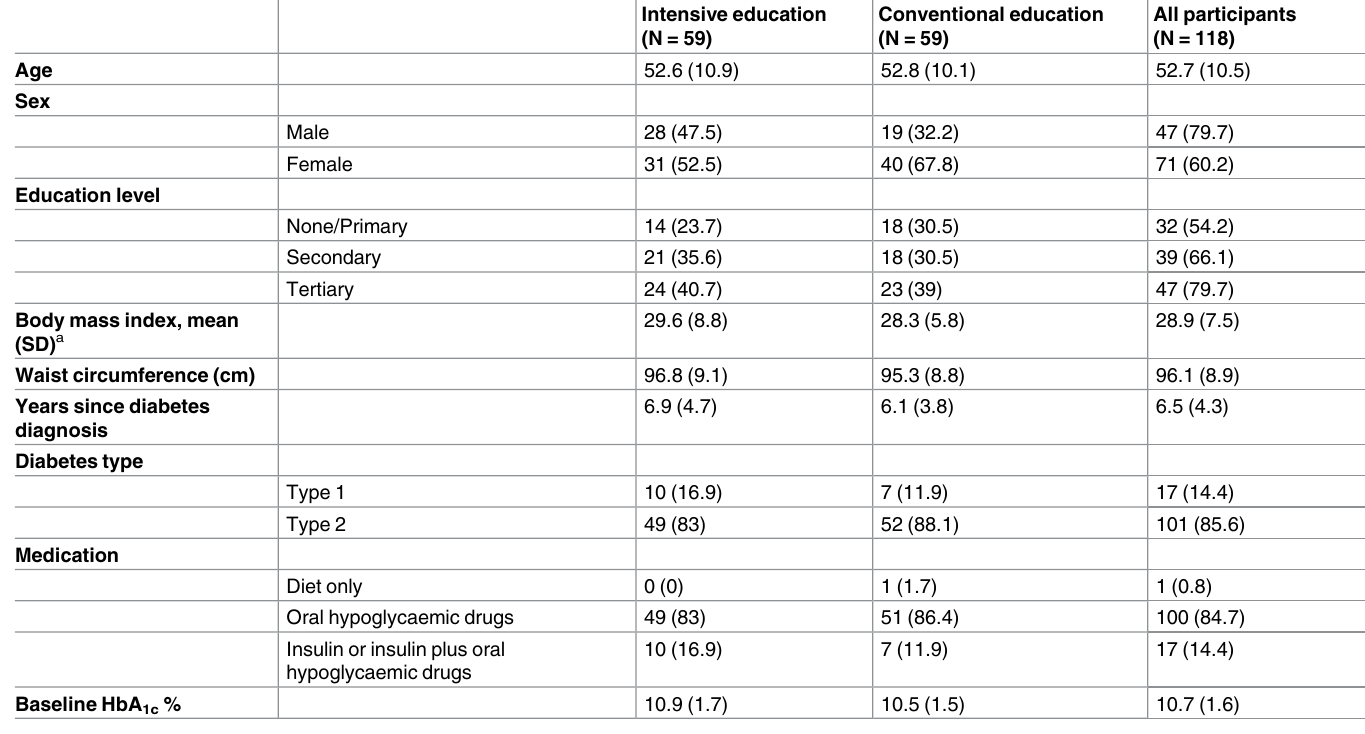
Values are n (%) for categorical variables or mean (SD). a Body mass index = weight (kg) / height (m 2